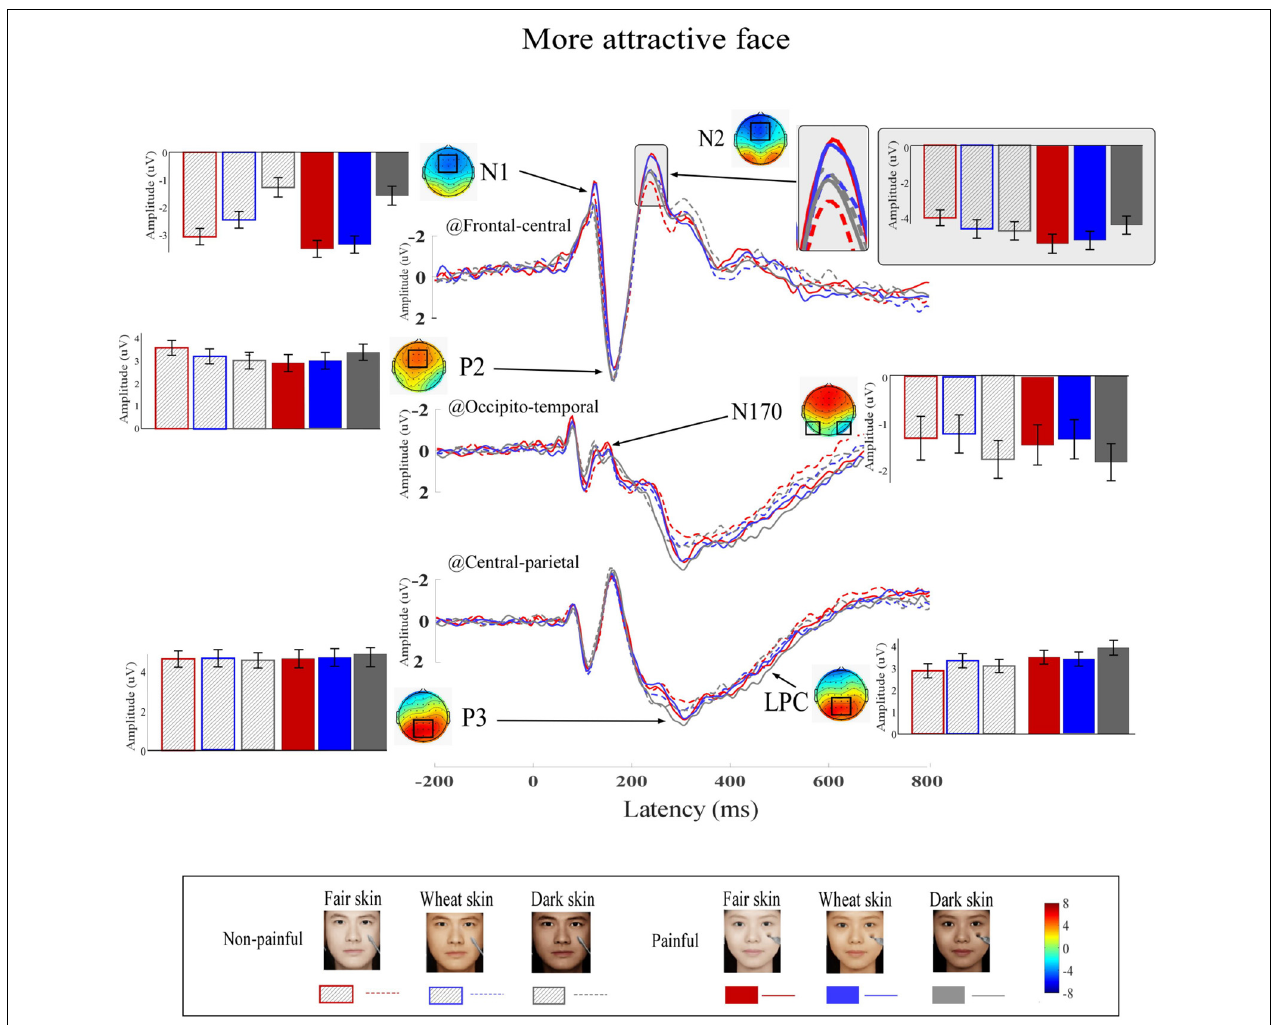
FIGURE 4 | Event-related potential (ERP) waveforms and scalp topography distributions to more attractive faces. ERP waveforms, bar charts, and scalp topographies elicited by the more attractive faces with fair (red), wheat (blue), and dark (gray) skin. These pictures had either non-painful (linear) or painful (solid) cues. Electrodes used to estimate ERP amplitudes are marked by black squares on their respective topographic distributions. Data in the bar charts are ERP amplitudes expressed as means ± standard error of the